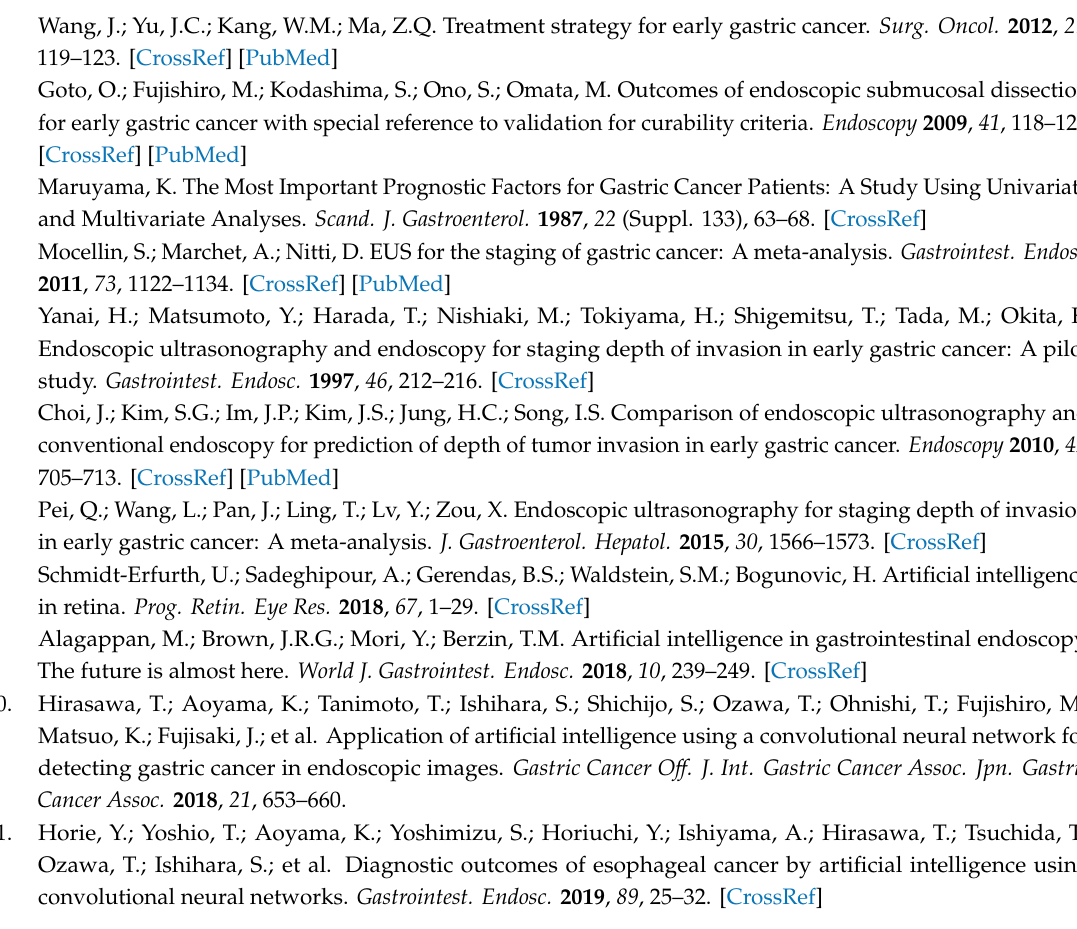
Figure S1: Examples of the Grad-CAM output extracted from each convolutional layer of the trained lesion-based VGG-16., Figure S2: Overview of the VGG-16-based model., Figure S3: Localization performances of activated regions extracted using the Grad-CAM method., Figure S4: Example of RGB color input images and their Grad-CAM results extracted from the last convolutional layer of VGG-16 and the lesion-based VGG-16., Figure S5: Comparisons of Grad-CAMs extracted from the last convolutional layer when a network was trained using two types of loss functions., Table S1: Groups for 5-fold cross validation., Table S2: Composition of the five folds cross validation dataset., Table S3: Diagnostic accuracy of the VGG-16 and lesion-based VGG-16. Author Contributions: Conceptualization: J.-H.K. Methodology: H.J.Y., S.K., J.-H.K., J.-S.K., S.-I.O., J.J.